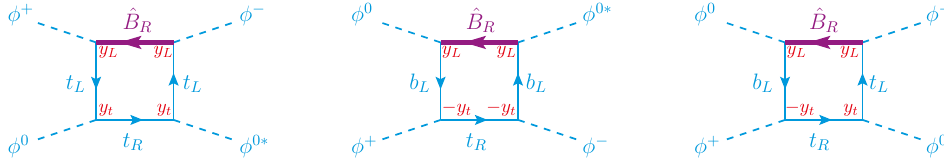
Figure 3 . The one-loop contributions to A [2] ( φ + φ 0 → φ + φ 0 ) from the BM model in eq. (5.9) proportional to y 4 (left) and y 4 (right). All external particles are going in. R L